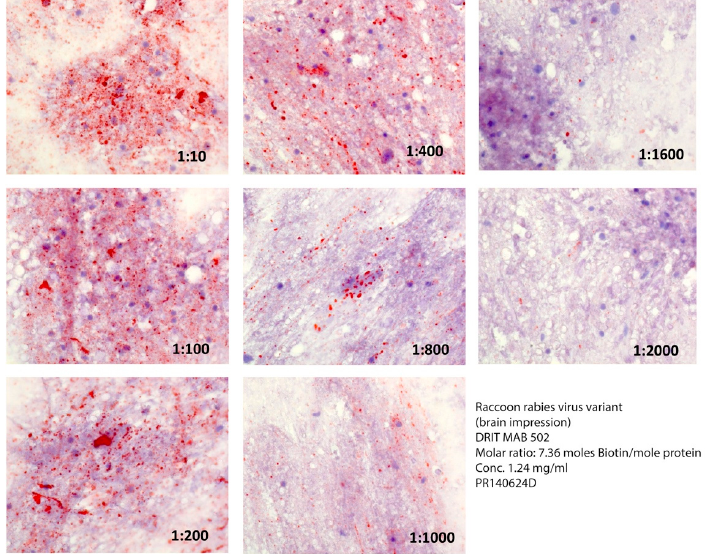
Figure 1. Comparative reactivity of serial dilutions of the DRIT MAB 502 (in PBS) at a ratio of 7.4 moles of biotin per mole of protein against a raccoon rabies virus variant. Rabies virus antigens appear as magenta inclusions against the bluish-purple background of uninfected CNS tissue in Figure 1, Figure 2 and Figure 3.